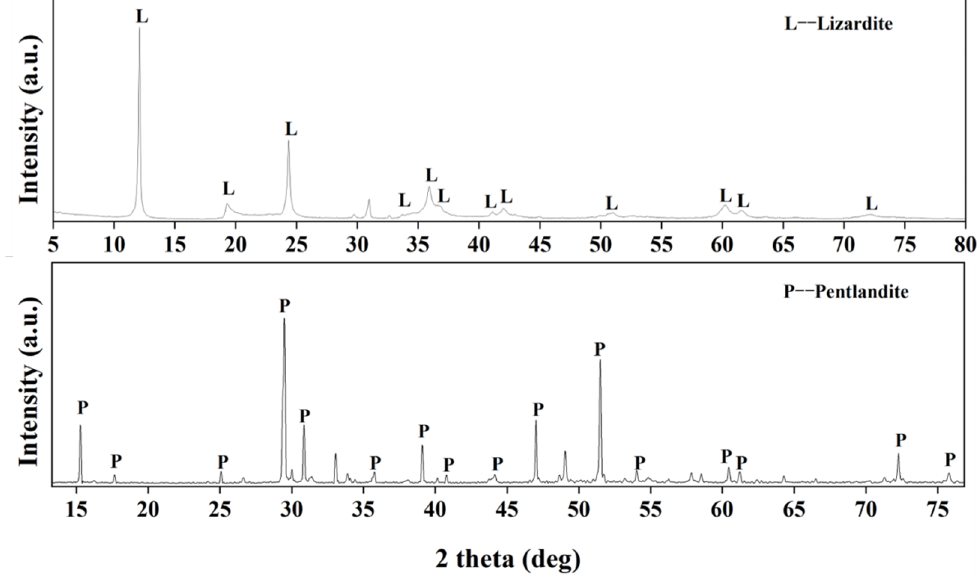
Figure 2. XRD spectra of serpentine (lizardite) and pentlandite samples.